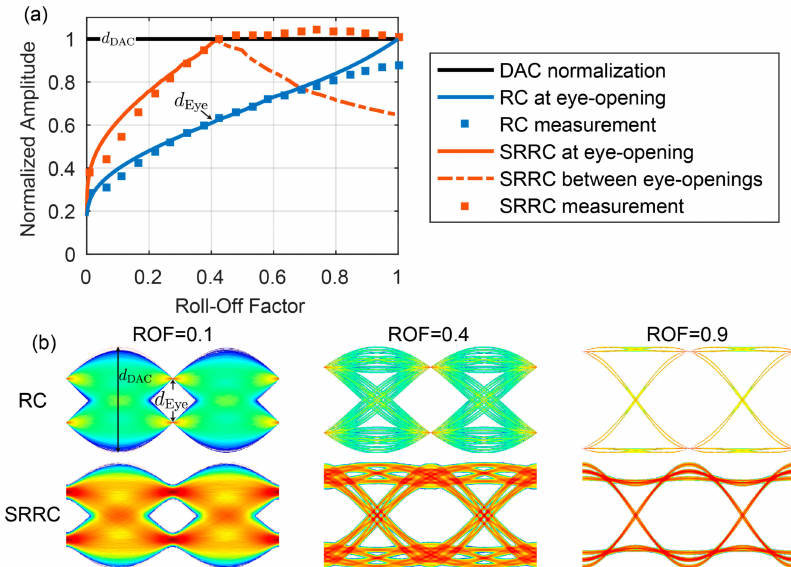
Figure 1. Investigation of transmitter electrical amplitude and its dependence on pulse shape. ( a ) Normalized amplitude against roll-off factor (ROF) for raised-cosine (RC; blue) and square-root-raised-cosine (SRRC; red) signals. Simulations for maximum amplitude at eye-opening (solid lines), maximum amplitude between eye-openings (dashed line), and electrical measurements of the root-mean-square (RMS) amplitude (square markers). ( b ) Simulated eye-diagrams of RC and SRRC signal with roll-off factors of 0.1, 0.4, and 0.9. The color indicates the probability of occurrence; a logarithmic color mapping was used to enhance the visibility of small details; all plots are normalized to the same maximum amplitude d_DAC (digital-to-analog